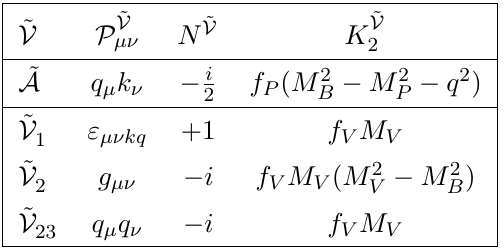
. See the text for details. 2